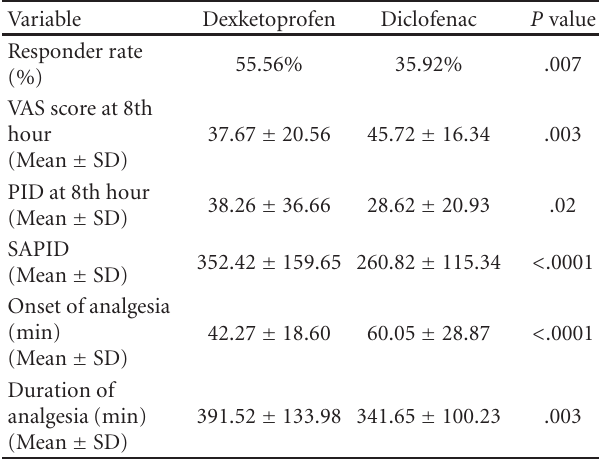
Table 2: E ffi cacy parameters of dexketoprofen and diclofenac.